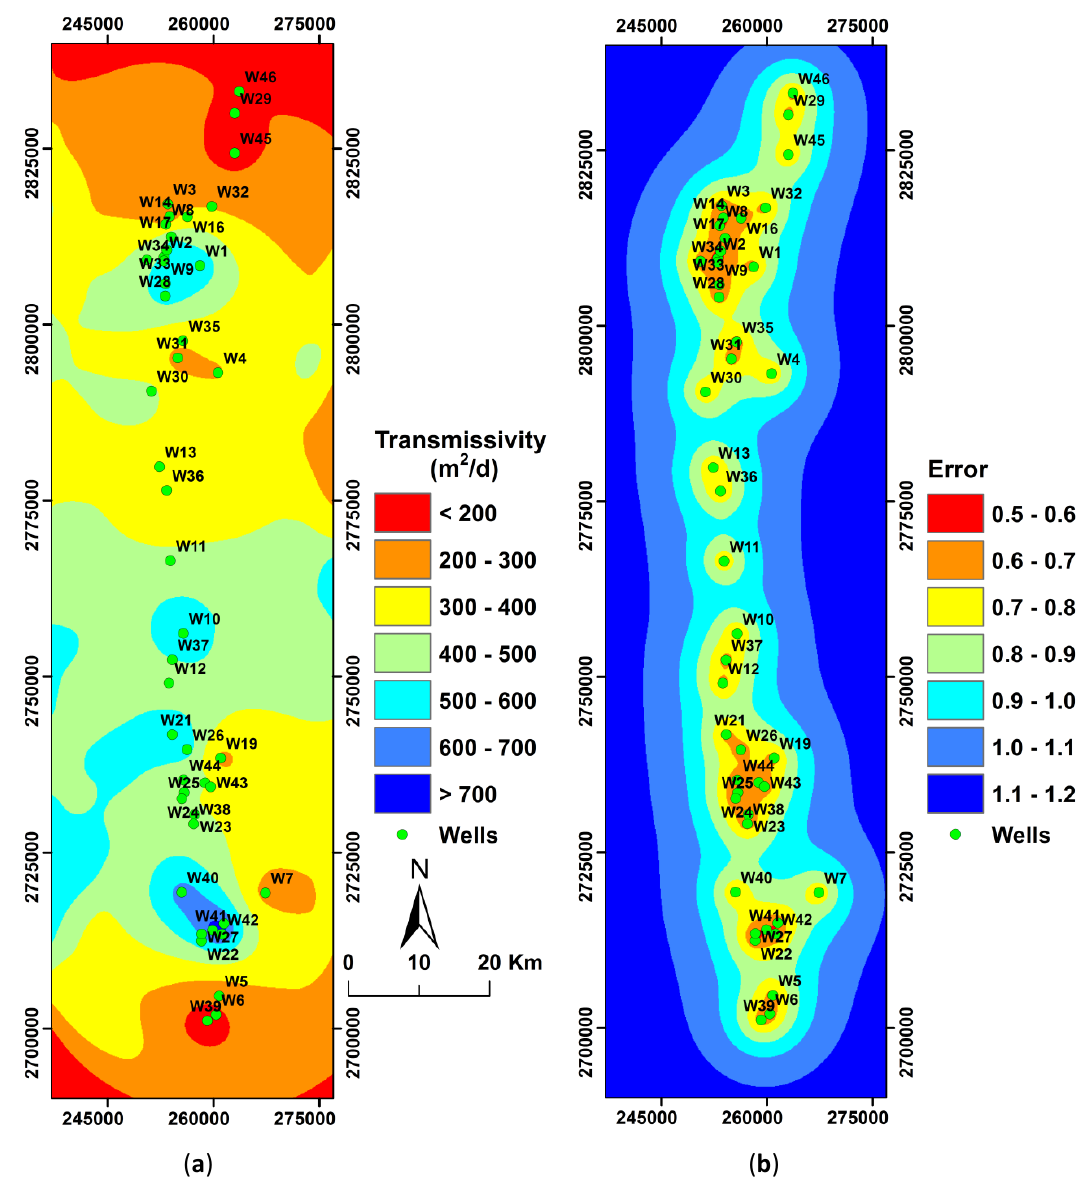
Figure 7. Map with the spatial distribution of the transmissivity of the Nubian sandstone aquifer in the Kharga oasis obtained by kriging interpolation ( a ) and the corresponding error map showing the spatial distribution of the estimated kriging variance divided by sample variance ( b ).